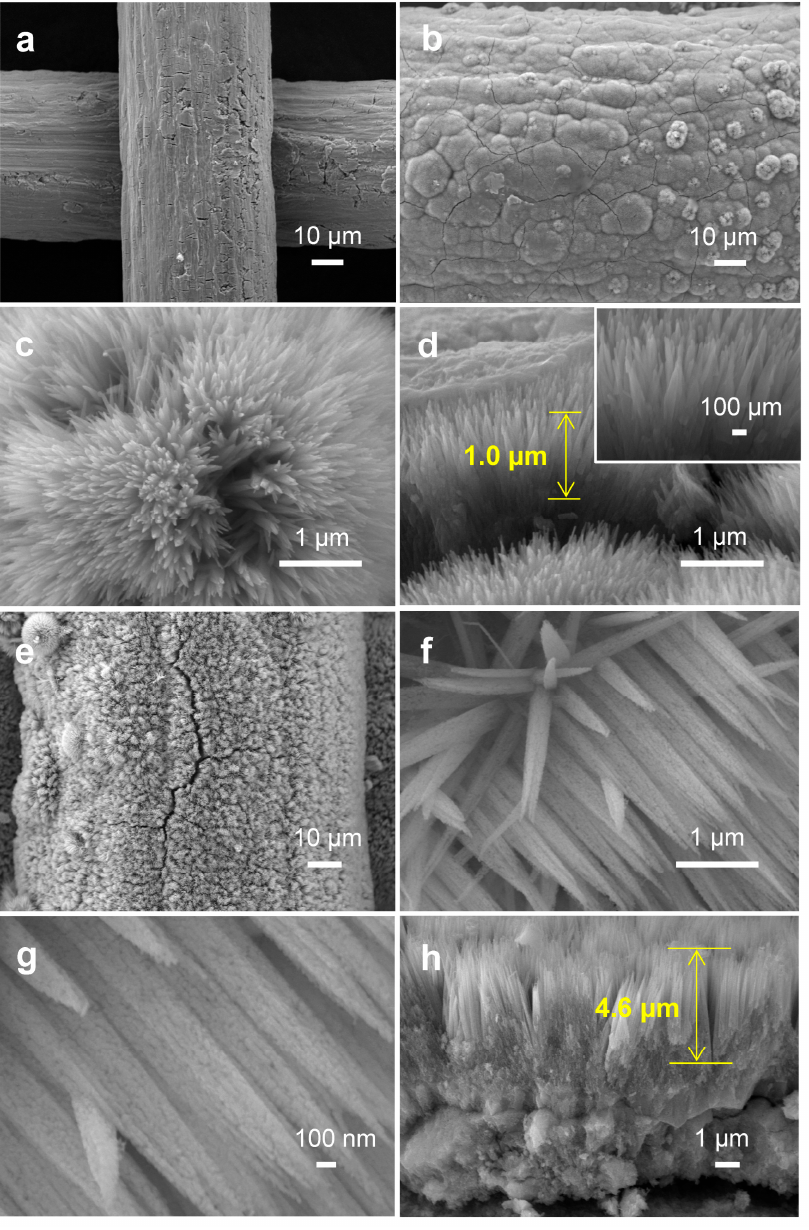
Figure 1. ( a ) FESEM image of Ti mesh. ( b , c ) FESEM image and ( d ) cross-sectional FESEM image of TiO 2 NNs. ( e – g ) FESEM image and ( h ) cross-sectional FESEM image of Co 3 O 4 .